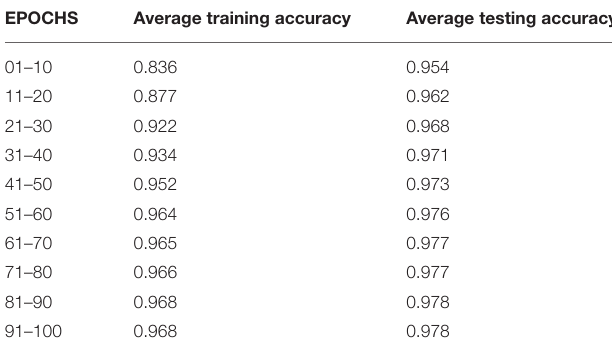
TABLE 4 | Comparison of training and testing accuracy of ETEODL over 100